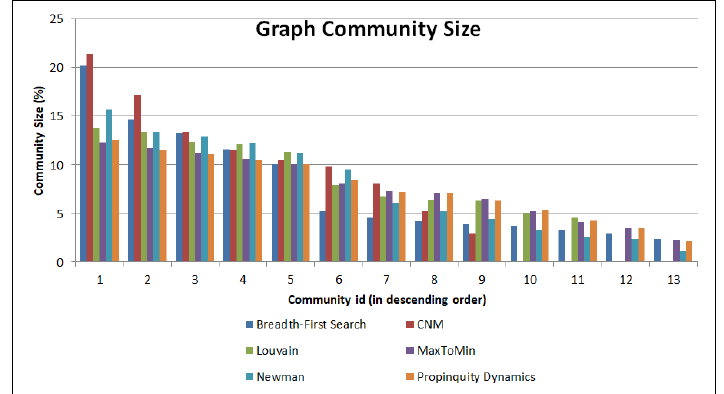
Figure 4. Chart of community Sizes (%) of Twitter